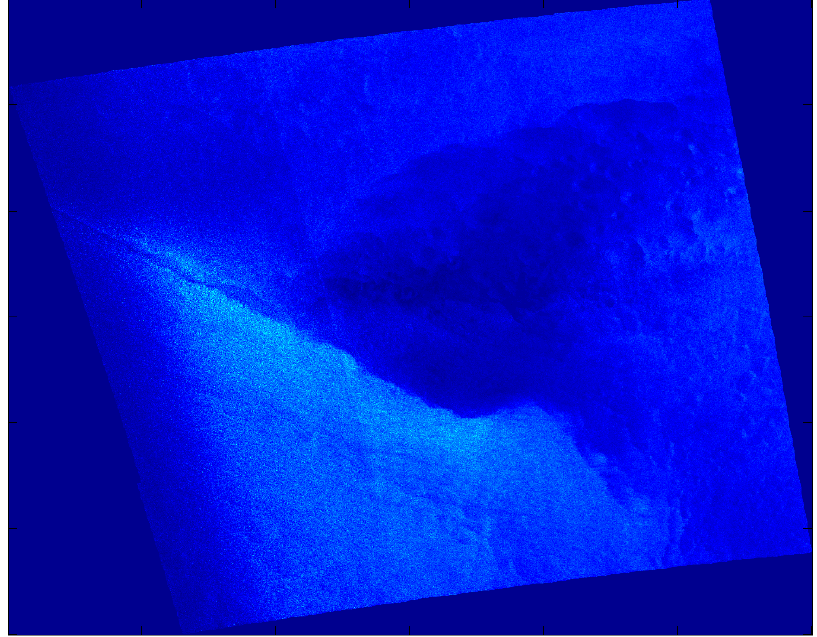
Figure 3. SDWS image for the case study, 0533 UTC on December 9, 2007. Brighter shades indicate higher wind speeds. The faint diagonal discontinuities parallel to the lateral borders of the image are artifacts resulting from satellite beam